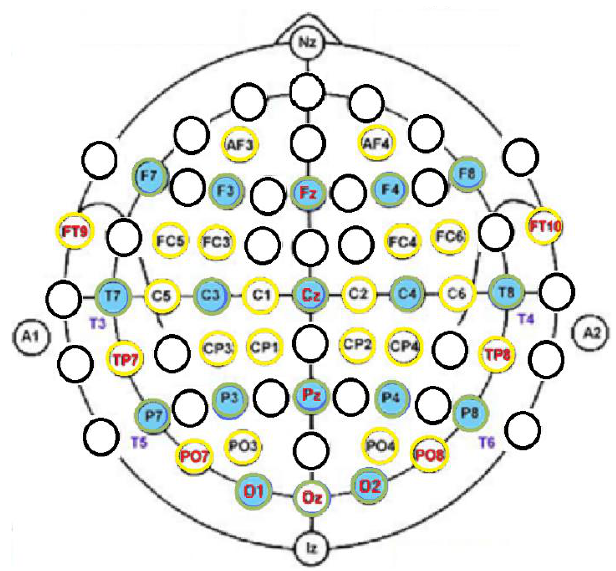
Figure 4. Forty sensor locations of the EEG system: 10-20 (green circles) and 10-10 systems (yellow circles). The 12 NF sensors are written in red. Table 3. Forty sensor locations covering adjacent brain areas. Twelve NF sensors (eight areas) are marked in bold.